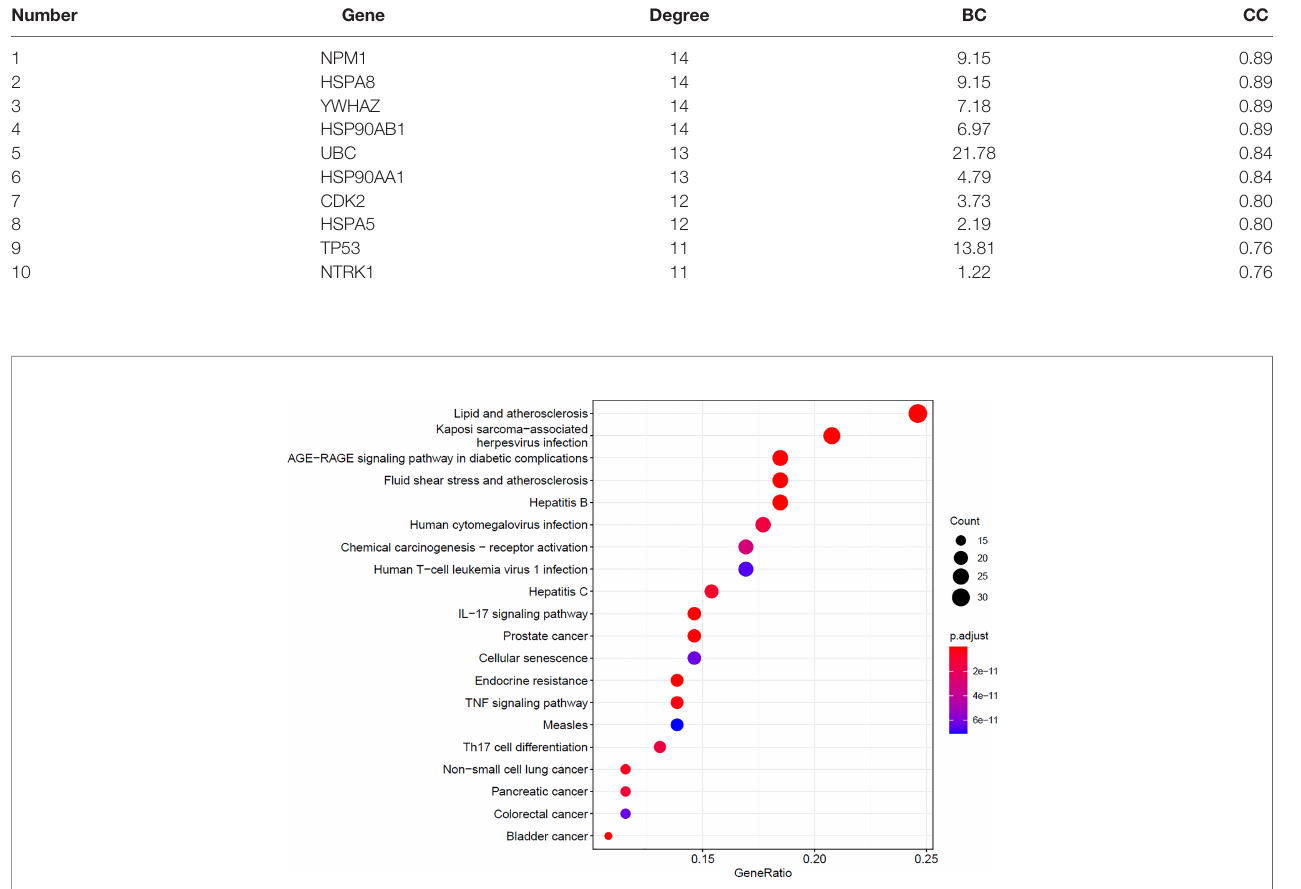
FIGURE 14 | KEGG enrichment